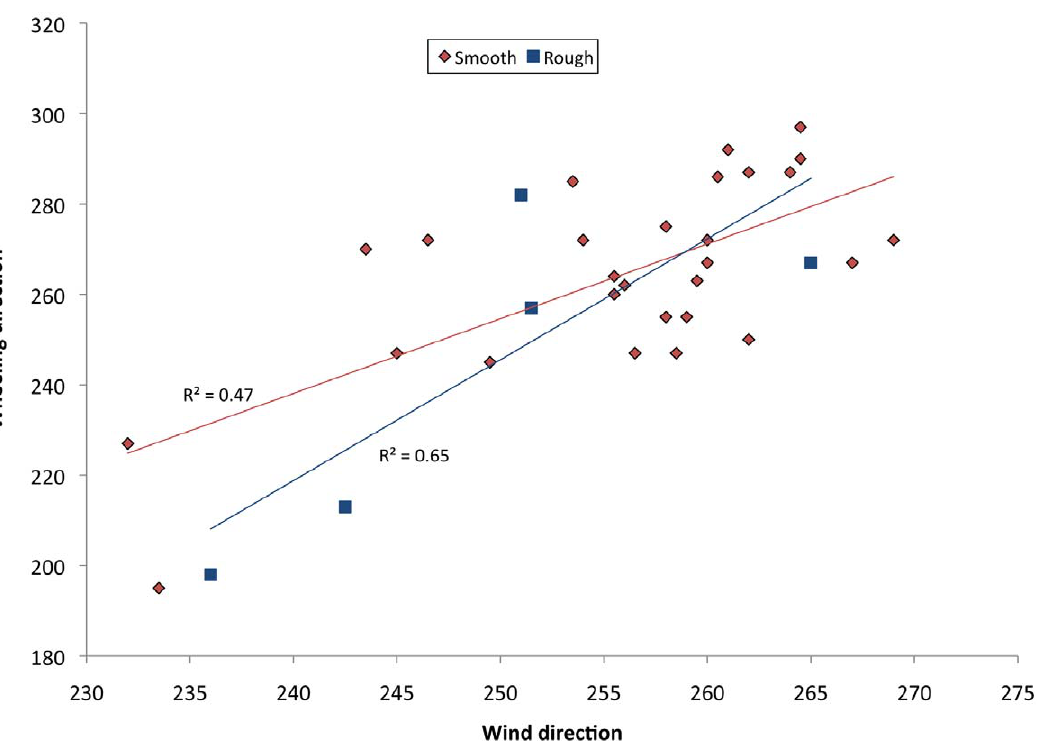
Figure 8. Effects of wind heading and substrate roughness on wheeling direction in C.dorsalismedia larvae. Regression coefficients are for substrate categories analyzed separately; see text and Table 4 for combined analyses.